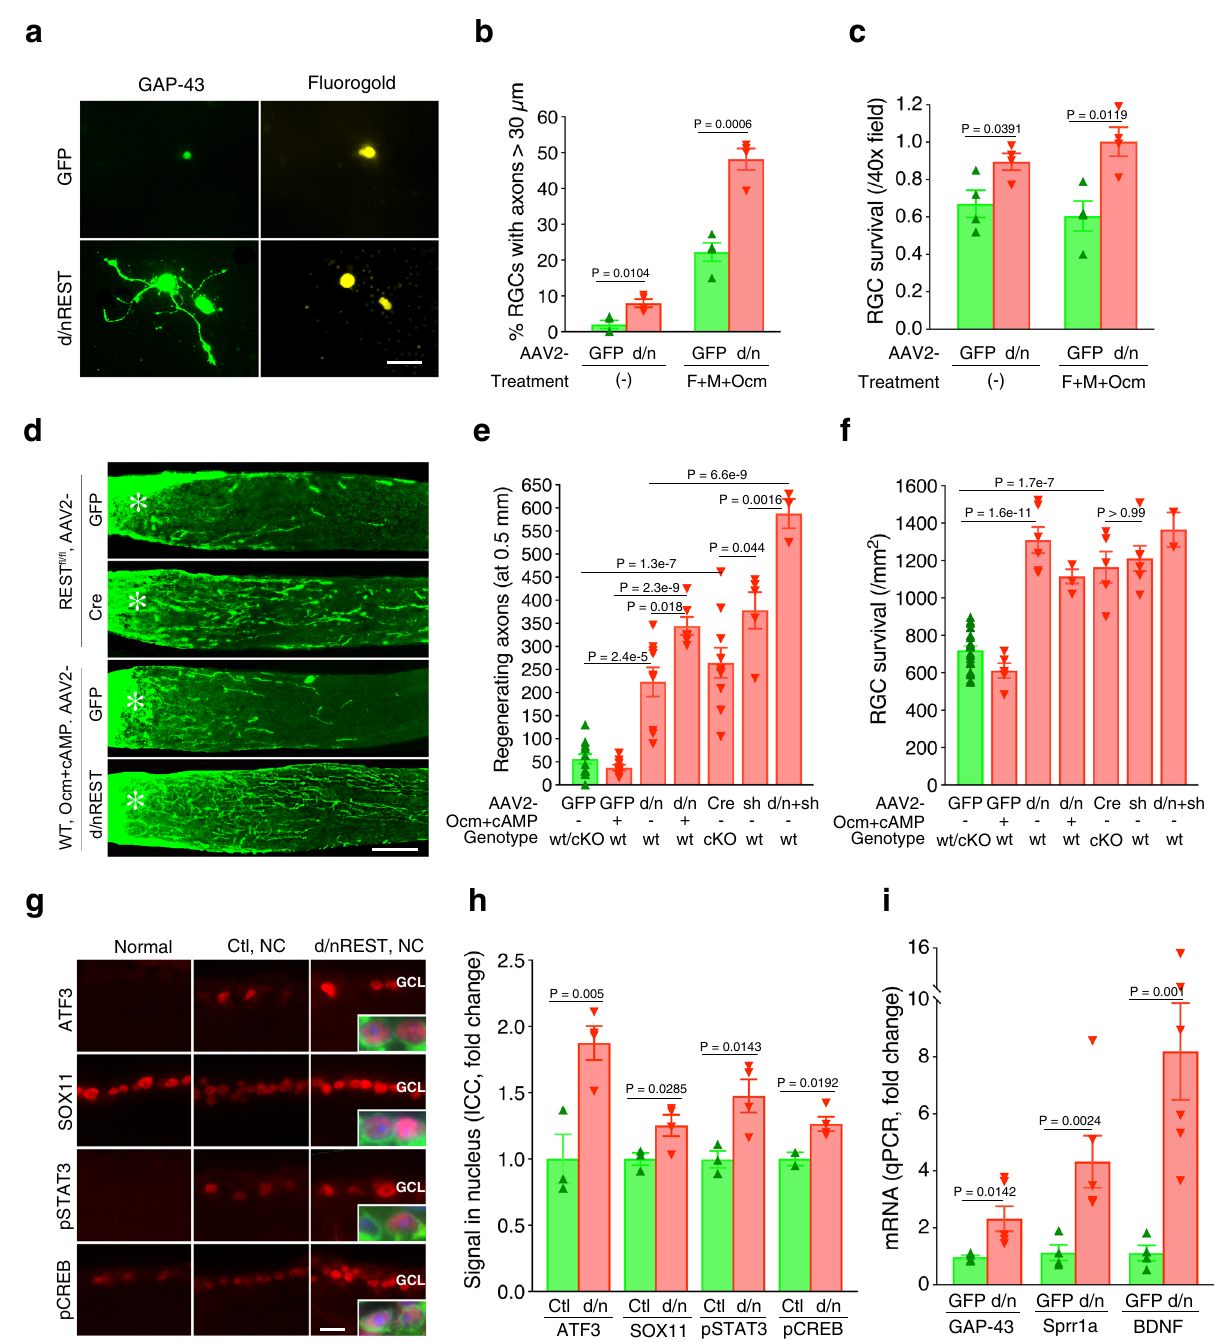
Fig. 8 | REST inactivation stimulates axon outgrowth from RGCs, optic nerve regeneration,andRGCneuroprotection.a – c EffectofRESTinactivationonadult ratRGCsinculture.MicereceivedintraocularinjectionsofeitherAAV2-d/nREST(d/ nREST) or AAV2-GFP (GFP) one week prior to retina dissociation. RGC culture was maintained in the presence or absence of forskolin (to elevate cAMP), mannose, andrecombinantoncomodulin(F+M+Ocm)for3days. a GAP-43immunostaining of RGCs (identi fi ed via retrograde labeling with Fluorogold injected into the superior colliculus 7 daysearlier). b Axon outgrowth represented as percentage of RGCswith axons ≥ 30 µ m. c RGC survivalinculture. d – f EffectsofRESTdeletion or antagonism on optic nerve regeneration and RGC survival in vivo. REST deletion was obtained by intraocular injection of AAV2-Cre in REST fl x/ fl x mice. REST antag- onism was obtained by intraocular injection of AAV2-d/n-REST (d/n) in wildtype (WT) mice. In addition to inactivating REST, some WT mice received recombinant Ocm plus CPT-cAMP (Ocm+cAMP). Control mice (green bar in E, F) were pooled from REST fl x/ fl x mice and WT receiving AAV-GFP. d Longitudinal sections of